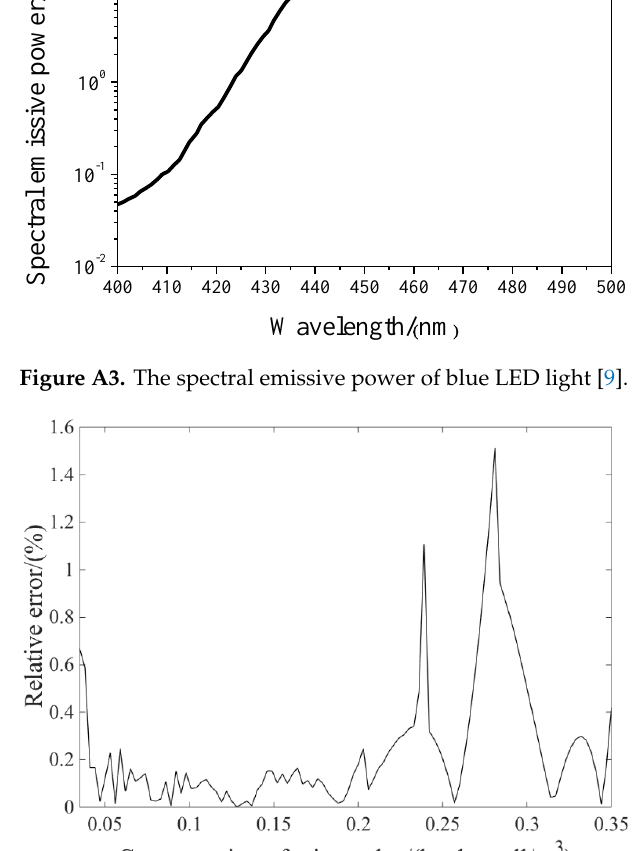
Figure A4. The relative error between the curve of the total hydrogen production rate varying with microalgae concentration at α = 1 and the fitting curve obtained using the improved quantum-behaved particle swarm optimization (IQPSO) curve fitting method.